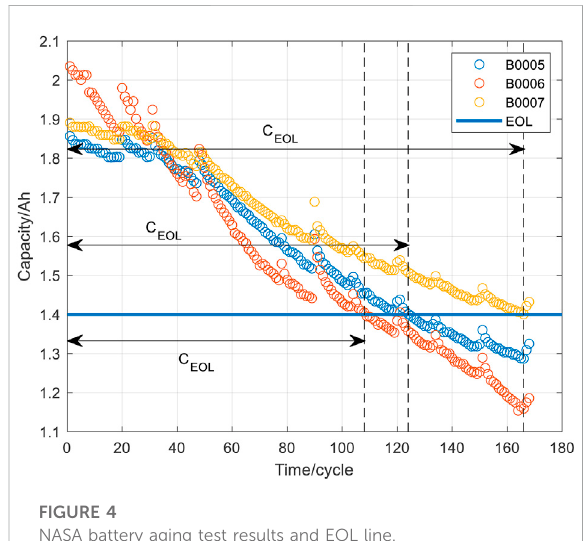
FIGURE 4 NASA battery aging test results and EOL line.